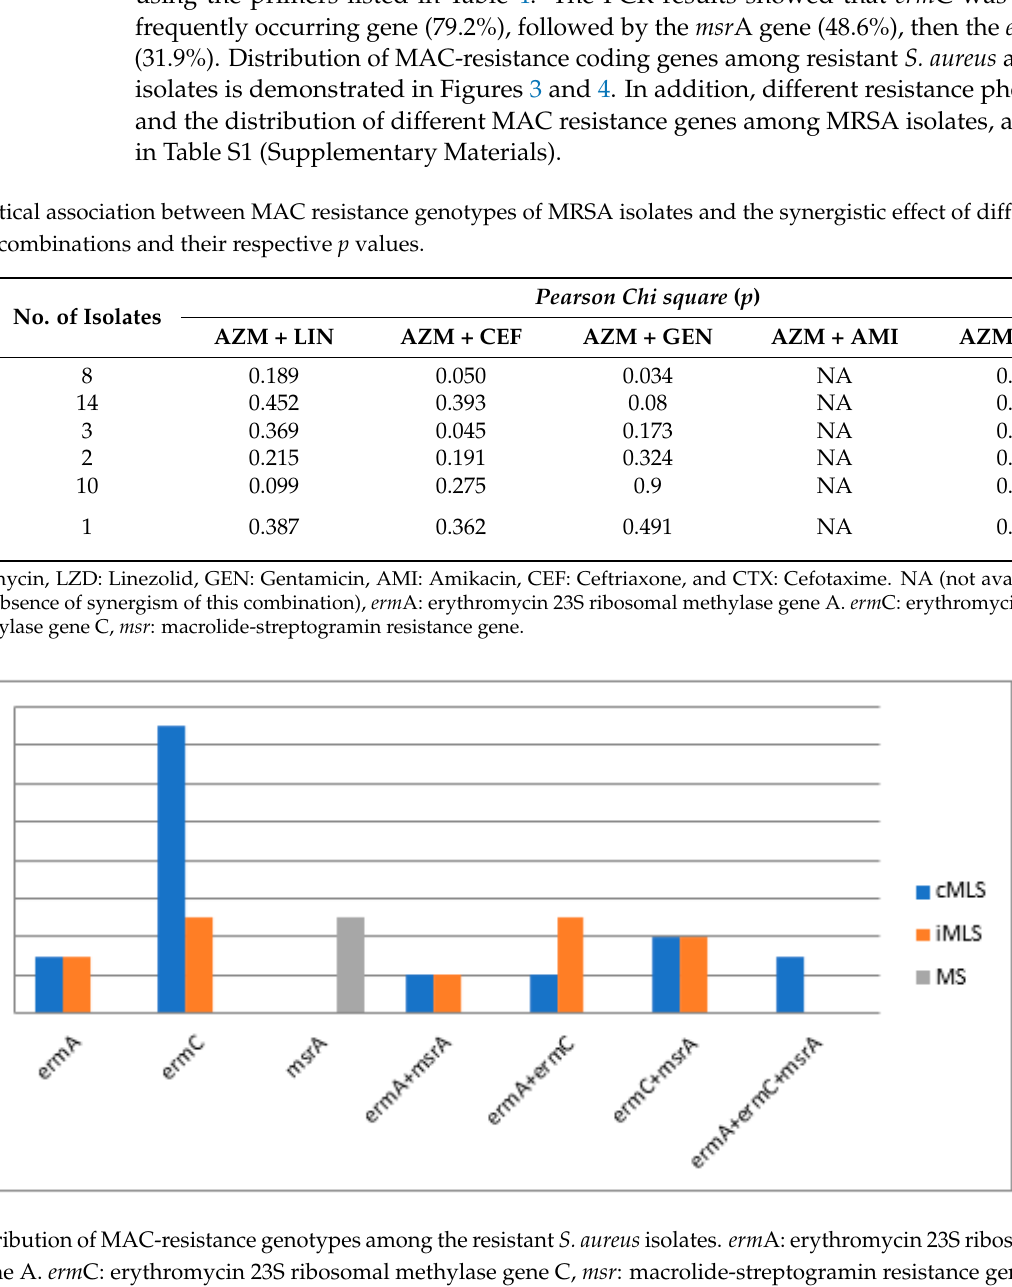
Figure 4. Distribution of MAC-resistance genotypes among the resistant coagulase-negative Staphylococcus sp. isolates. erm A: erythromycin 23S ribosomal methylase gene A. erm C: erythromycin 23S ribosomal methylase gene C , msr : macro- lide-streptogramin resistance gene.